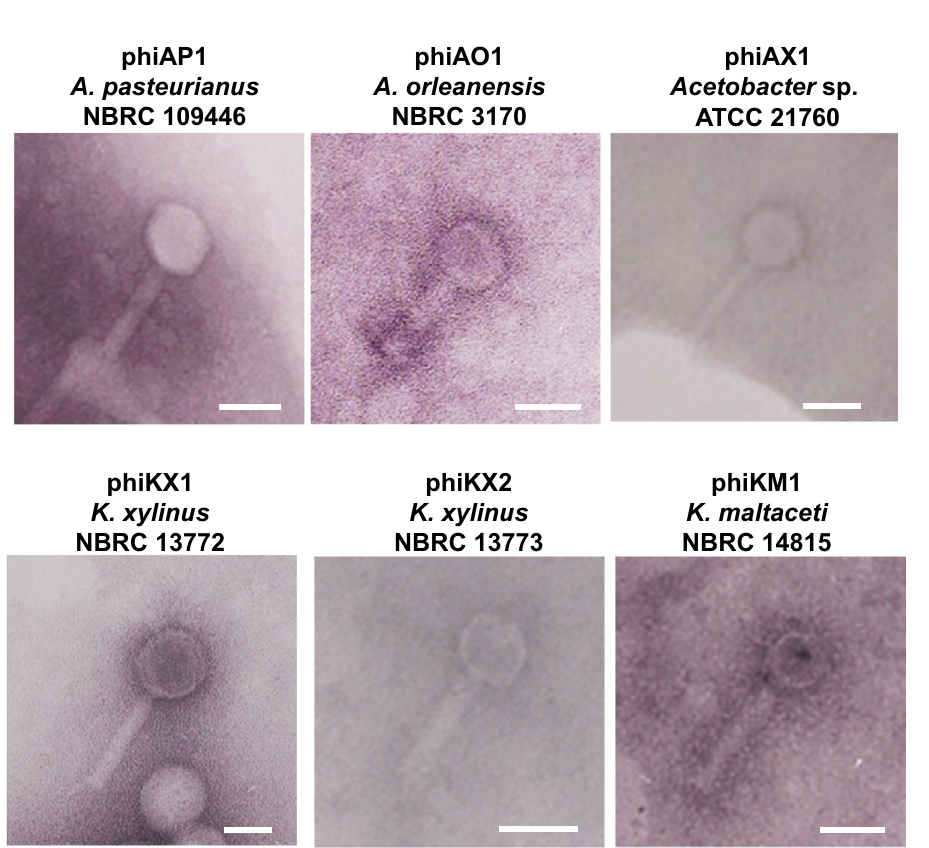
Figure 1. TEM photographs of temperate phages produced by acetic acid bacteria. Phage particles of acetic acid bacteria (AAB) were photographed with TEM. Fractions were prepared from AAB grown in YPG-1% glucose medium containing mitomycin C (MMC) with shaking culture for 48 h. Bars, 50